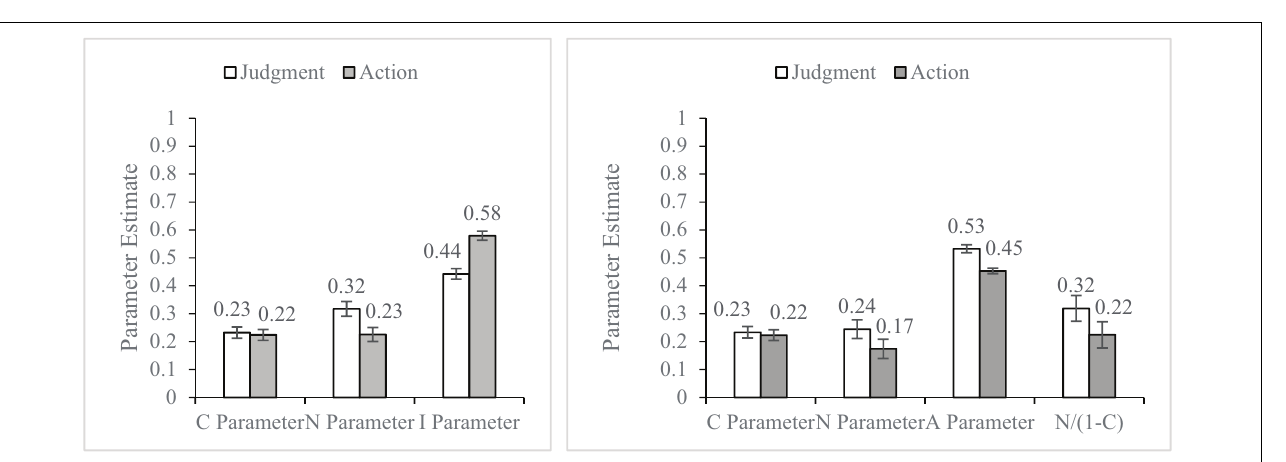
Frontiers in Psychology |